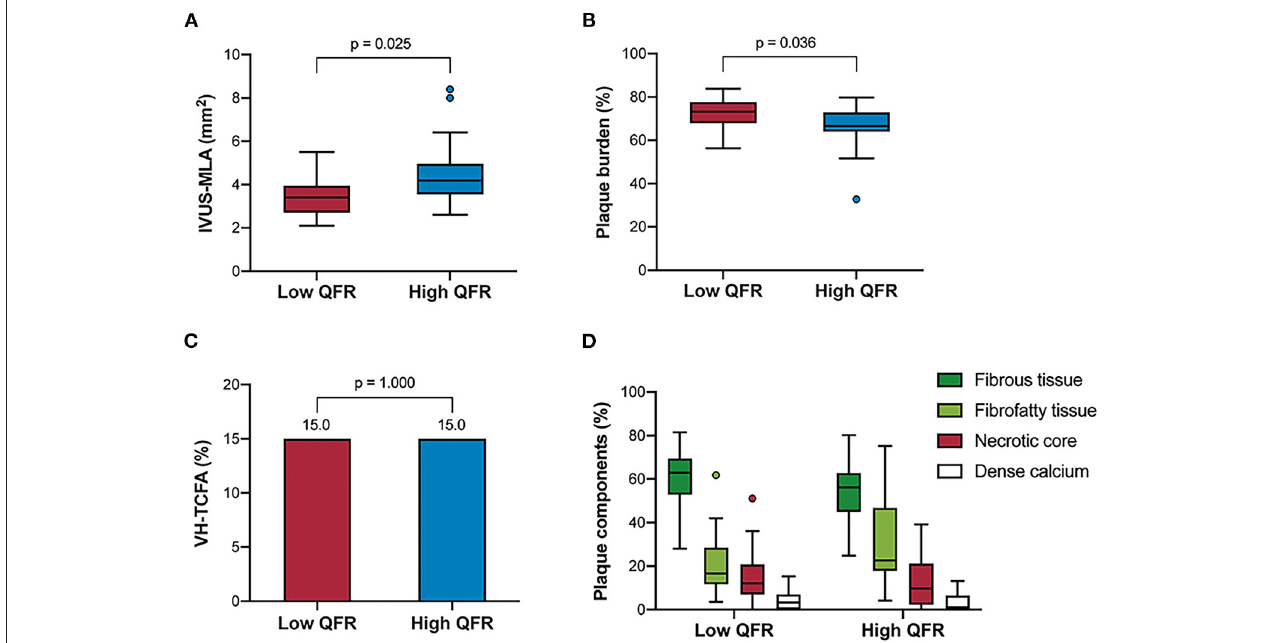
FIGURE 4 | IVUS-derived morphological characteristics stratified by QFR groups. The grayscale IVUS cohort ( n = 49) showed that the high QFR group had a larger IVUS-MLA (A) but a smaller plaque burden (B) compared to the low QFR group. However, the VH-IVUS subgroup ( n = 40) showed that there was no significant difference in the frequency of VH-TCFA, (C) and plaque components (D) between the groups. VH-TCFA, virtual histology-thin cap fibroatheroma; other abbreviations as in Figures 1 , 2